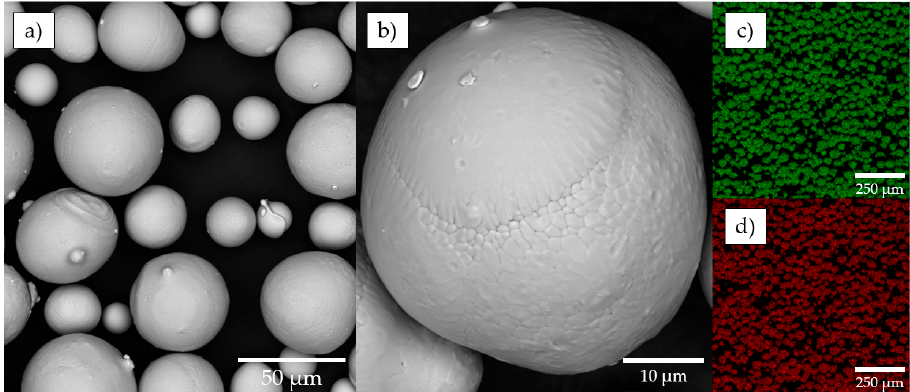
Figure 4. Results of the SEM powder analysis: ( a ) SEM image of powder; ( b ) powder particle with dendritic fragments under high magnification; ( c ) Ni K α 1; ( d ) Ti K α 1.